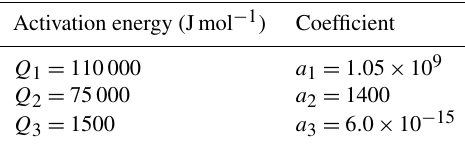
Table 1. Preferred set of values for the three activation energies and associated pre-exponential